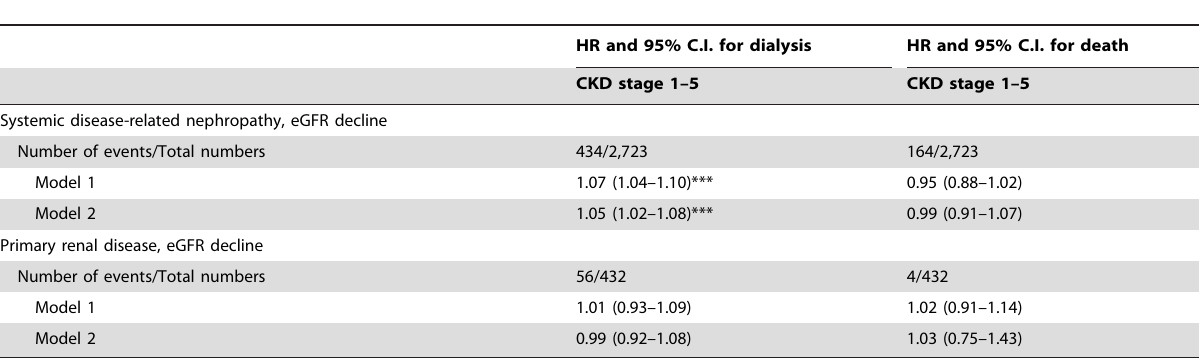
(Table 3). The crude eGFR decline and adjusted (age, gender, eGFR decline, proteinuria, ACEI/ARB, and antilipemic agents) risk of dialysis and all-cause mortality in those with SDRN and PRDs are listed in Table 3. Several disease types categorized as SDRN (e.g., multiple myeloma) that could potentially be successfully treated were excluded. In addition, PRDs (e.g., Crescentic GN or RPGN, obstructive nephropathy, acute Table 3. Association of eGFR decline with outcomes during study period by different disease etiologies.